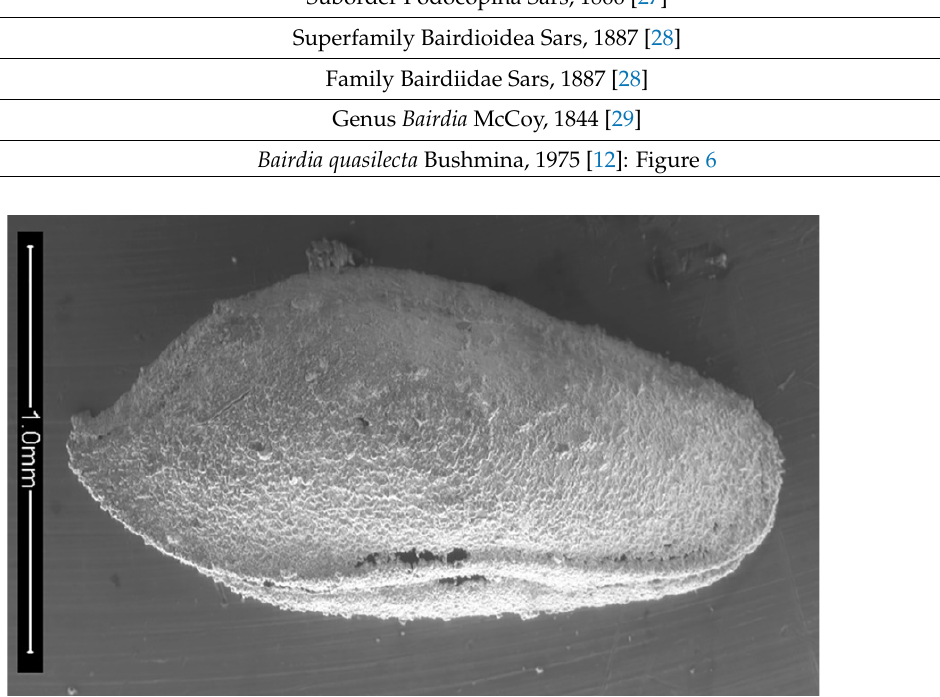
Figure 6. Bairdia quasilecta Bushmina, 1975, right valve, oblique lateral view. IGM 5011(3). Scanning electron micrograph (secondary electrons). Specimen is slightly rotated on the long axis to show the ventral border. Scale bar = 1mm.